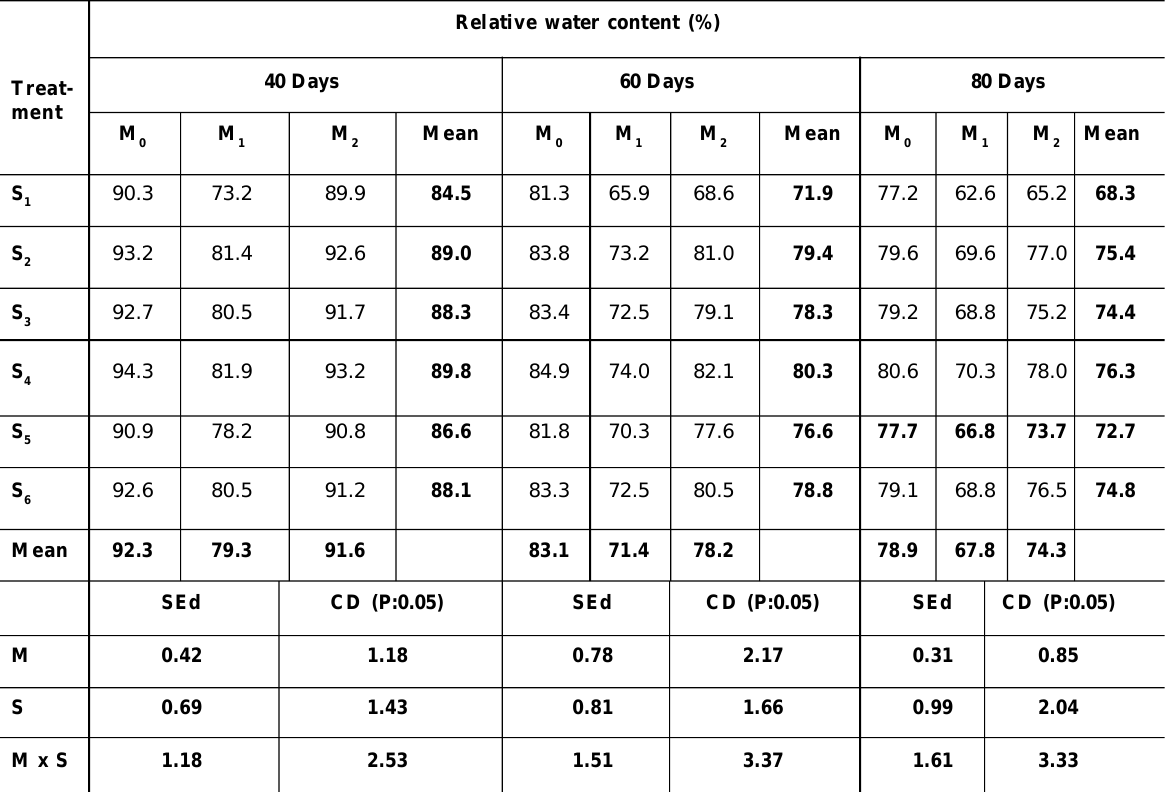
Table 1: Effect of plant growth regulating chemicals on relative water content (%) in bhendi hybrid CO under moisture stress conditions Relative water content (%) Treat- 40 Days 60 Days 80 Days ment